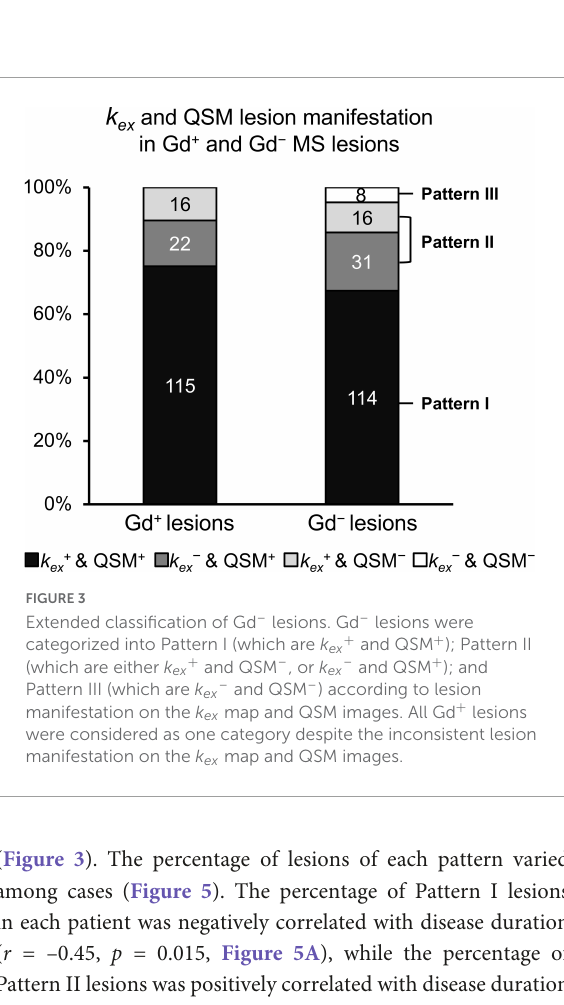
( Figure 3 ). The percentage of lesions of each pattern